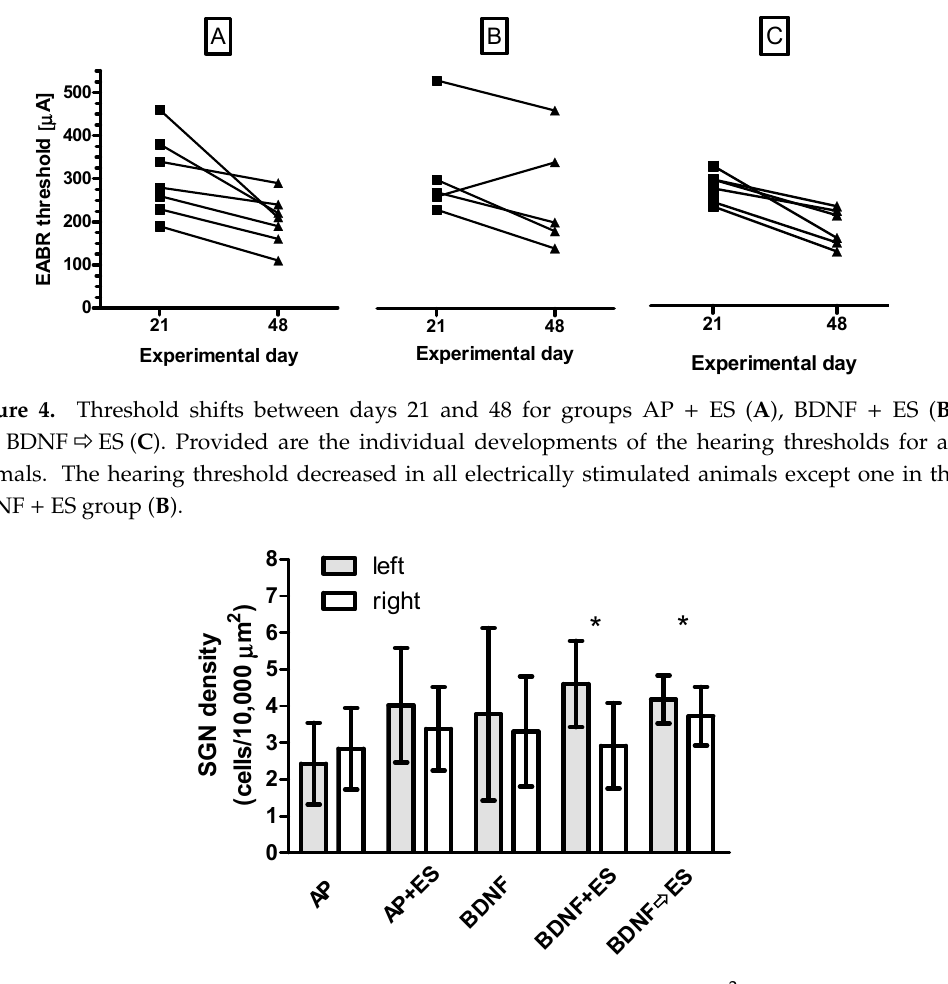
Figure 5. Density of surviving neurons (number of neurons per 10,000 µm 2 ) for treated (left) and untreated (right) cochleae (mean ± SD). The density is increased on the treated side only in both groups receiving BDNF and ES. No differences were found when comparing the treated sides of all groups. * p < 0.05.